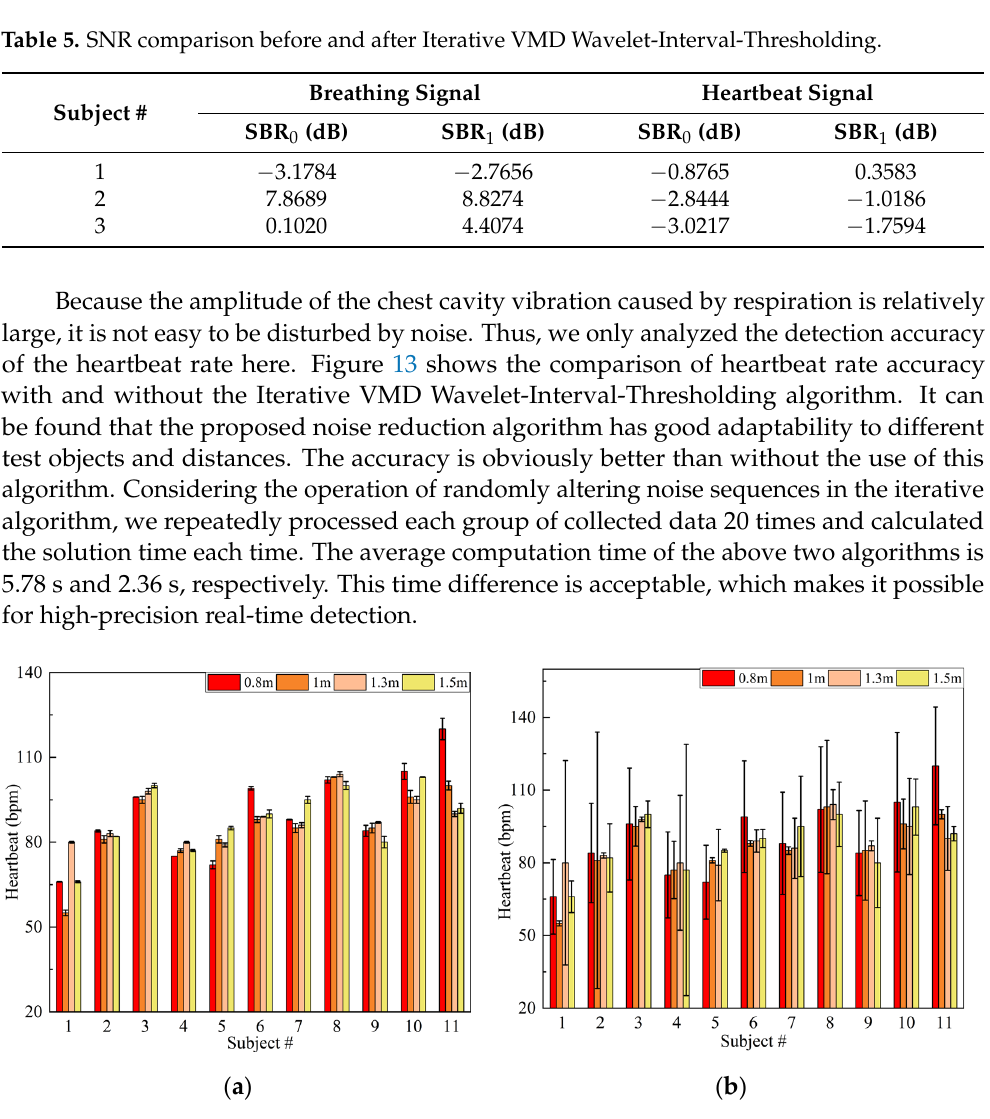
Figure 13. Experimental results of the heartbeat ( a ) with and ( b ) without Iterative VMD Wavelet- Interval-Thresholding algorithm. (The bars represent the reference values and the error bars represent the absolute errors of the measurement values obtained by the two algorithms compared to the reference values.).